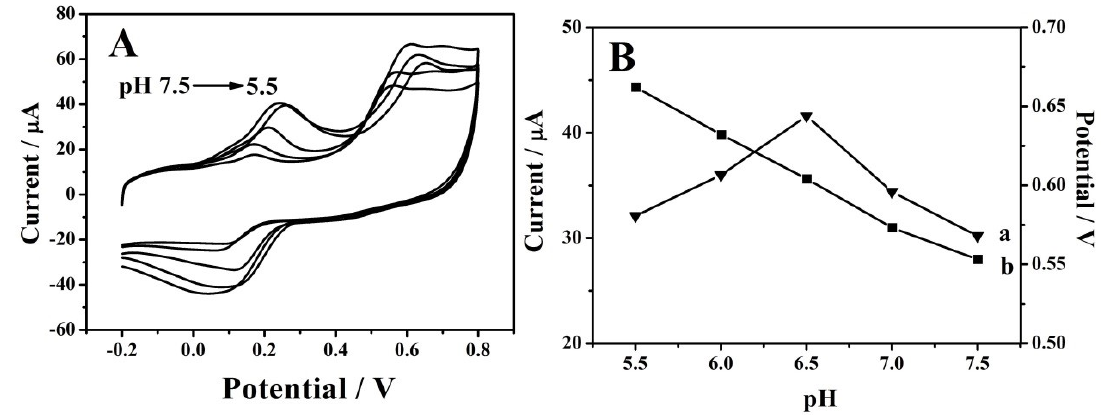
Figure 3. ( A ) CVs of BPA (0.1 µ M) using MoSe 2 /rGO/GCE with different pHs (from 5.5–7.5); ( B ) variation of peak current (a) and peak potential (b) with different pHs. The scan rate was 100 mV/s, and the electrolyte was 0.1 M